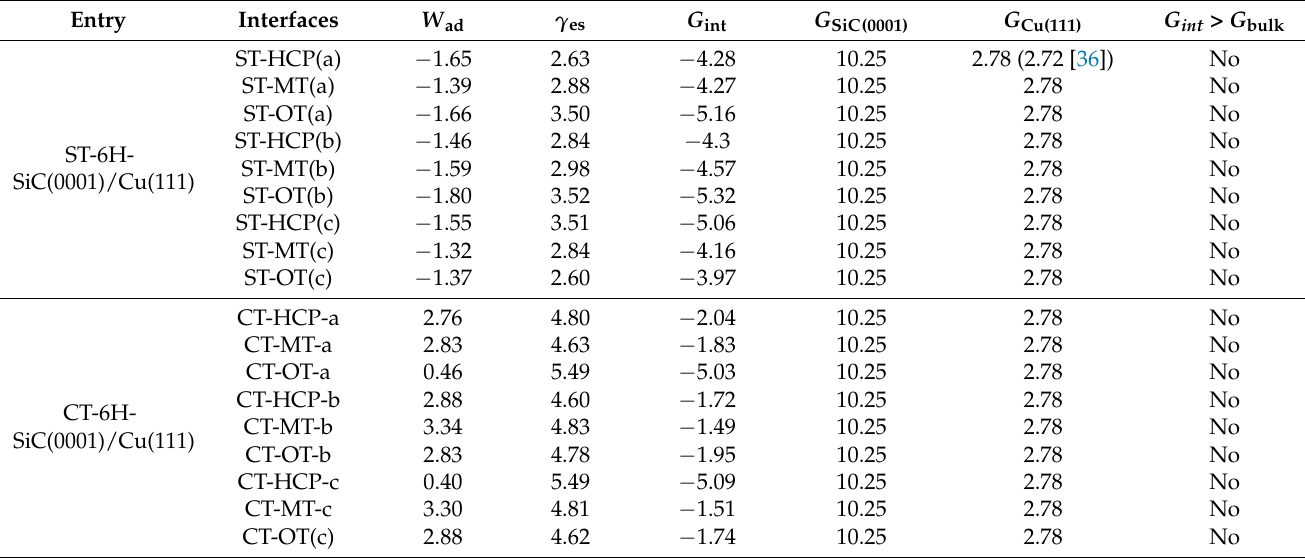
Table 5. Interfacial fractural mechanism parameters for SiC 2 /Cu interfaces (J · m − 2